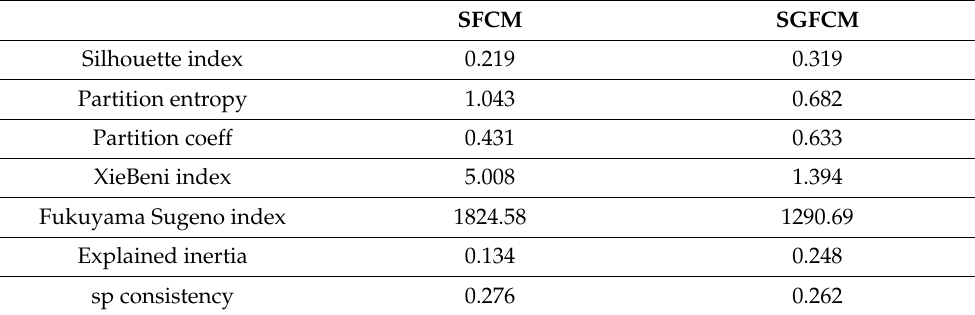
Table 5. Comparison of the indices between SFCM and SGFCM.